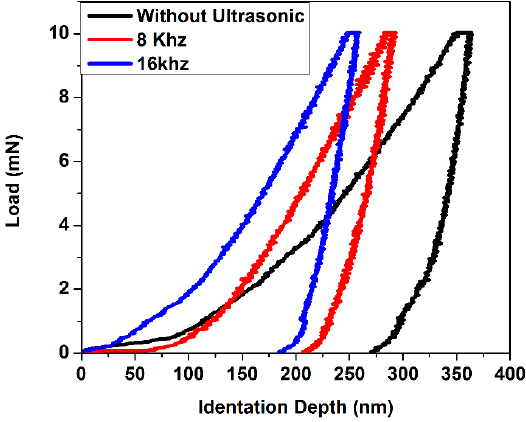
Figure 3. Load vs. displacement curve of TiN coated samples after ultrasonic treatment at 8kHz and 16 kHz Table 1. Summary of output data from the nanoindentation test for ultrasonic treatment at 16 kHz for different holding times.